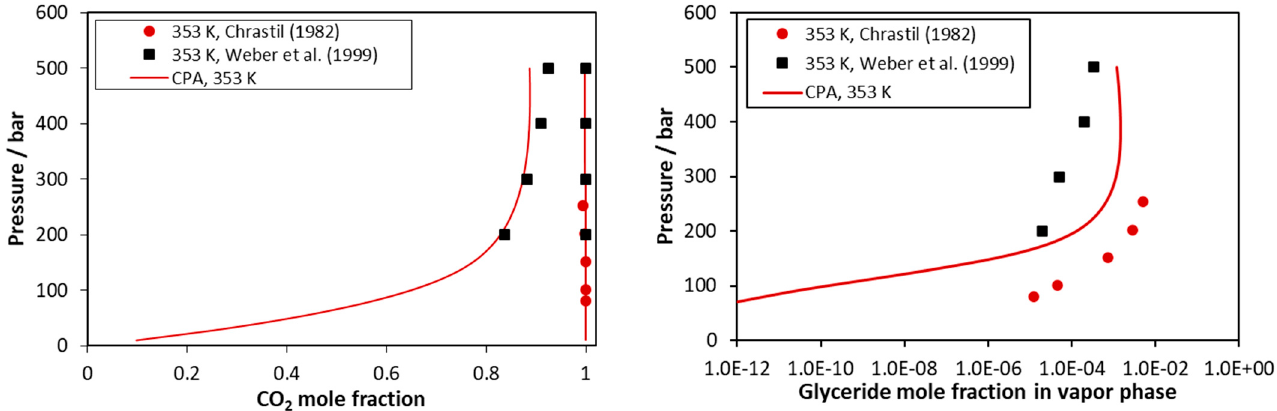
Figure 8. CO 2 –triolein VLE at 353 K. Experimental data [51,53] and CPA correlations using the binary interaction parameter of Table 5.